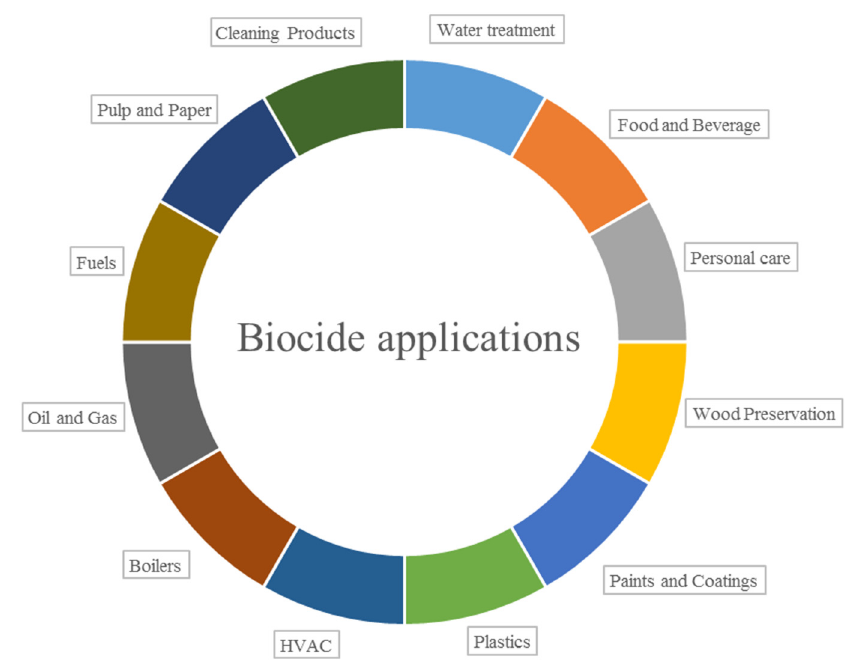
Figure 3. Biocide applications (HVAC—heating, ventilation, and air conditioning) .